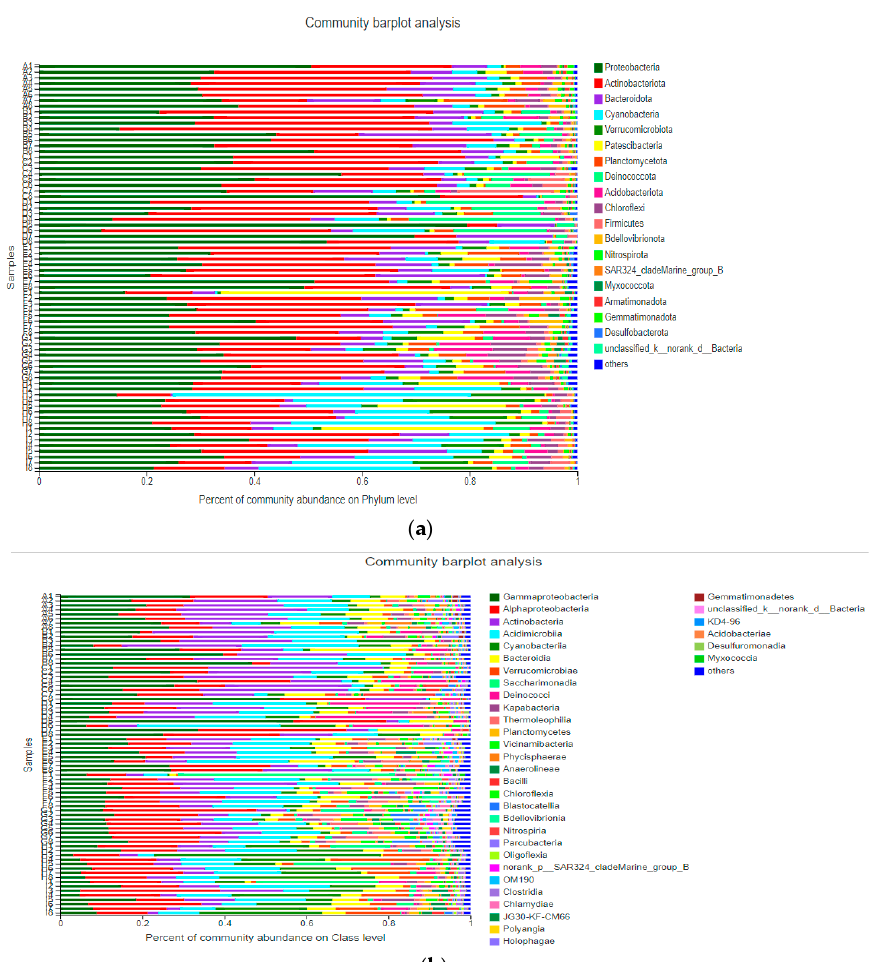
Figure 3. Composition of the bacterial community in Qingcaosha Reservoir from April to December 2019 (phylum and class levels). The Y-axis is the name of the sample, the X-axis is the proportion of the species in the sample, the different colored columns represent different phylum ( a ) and class ( b ), and the length of the columns represents the proportion of the species.